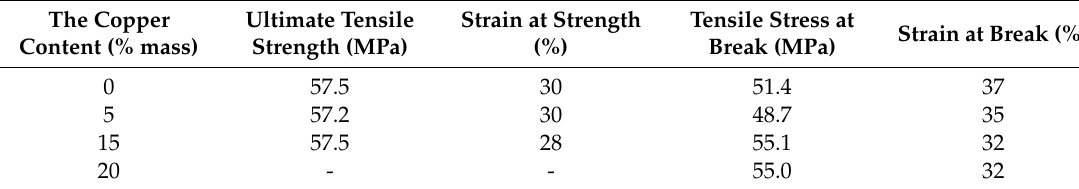
Table 5. Physicomechanical properties of metal-filled